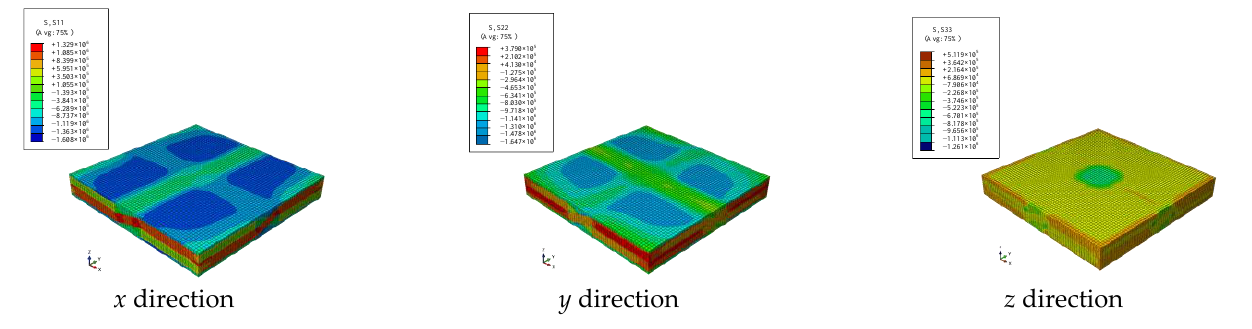
Figure 7. The stress distribution under load boundary conditions.